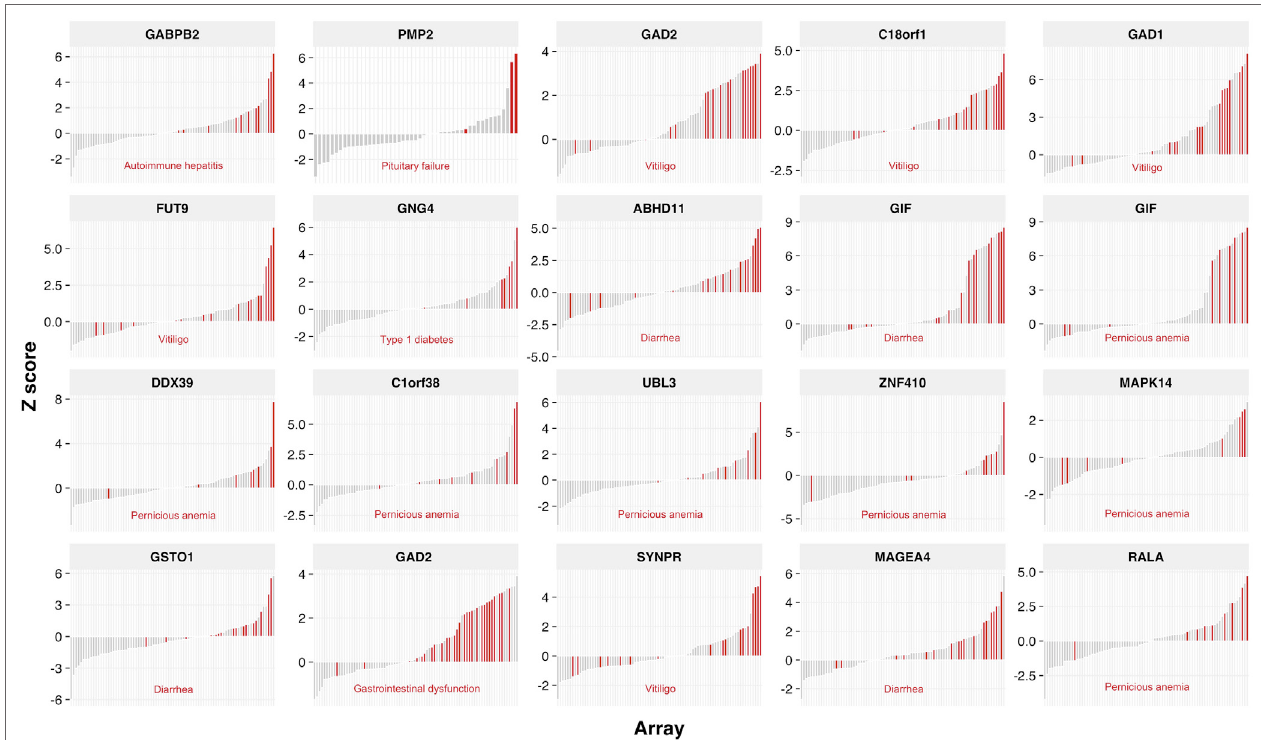
FigUre 3 | Autoantibody reactivities associated with APECED patients clinical and phenotypic features. Association of Protoarray z -scores with corresponding clinical manifestations. The height of the bar depicts z -score of the sample, red bars represent samples positive for a given manifestation (indicated below each plot). All other bars in gray represent autoantibody levels in patient samples without the certain clinical manifestation. Only statistically significant associations are shown ( p < 0.05) and adjusted across 900 most reactive proteins on Protoarray using moderated contrast t